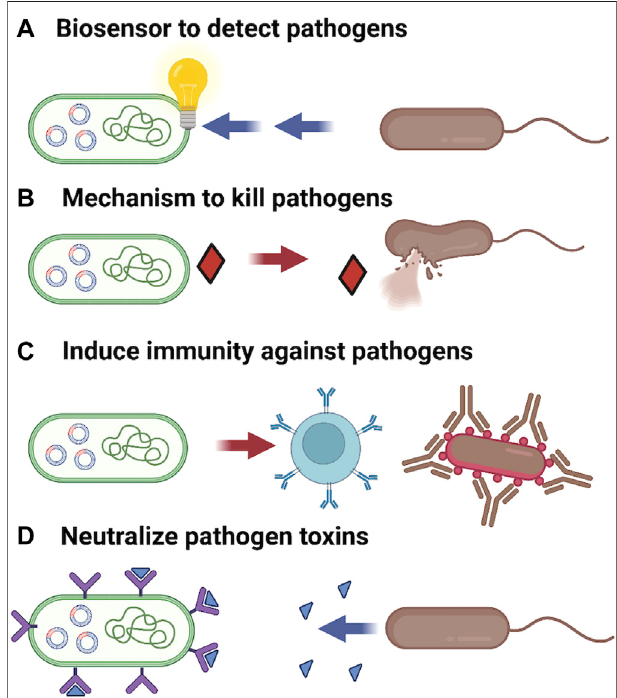
FIGURE 3 | Probiotics can be engineered with improved functionalities to inhibit pathogens. (A) Receptors wired to a genetic circuit capable of providing an easily measurable response can act as biosensors to detect and even quantitate pathogens presence. (B) Secretion of bacteriocins and lyticenzymescanbeprogramedintofavorablestrainstodegradebio fi lmsand allowing speci fi c killing of pathogenic microbes. (C) Engineering expression of pathogens surface markers on harmless probiotic strains can provide for vaccination to increase immunity against pathogens. (D) Expression of receptors for bacterial toxins can allow a probiotic to act as a biological vacuum to neutralize toxins and reduce tissue damage from infection. Additionally, probiotic strains can be programmed to secrete quorum sensor antagonists to reduce expression of virulence factors. Figure constructed using